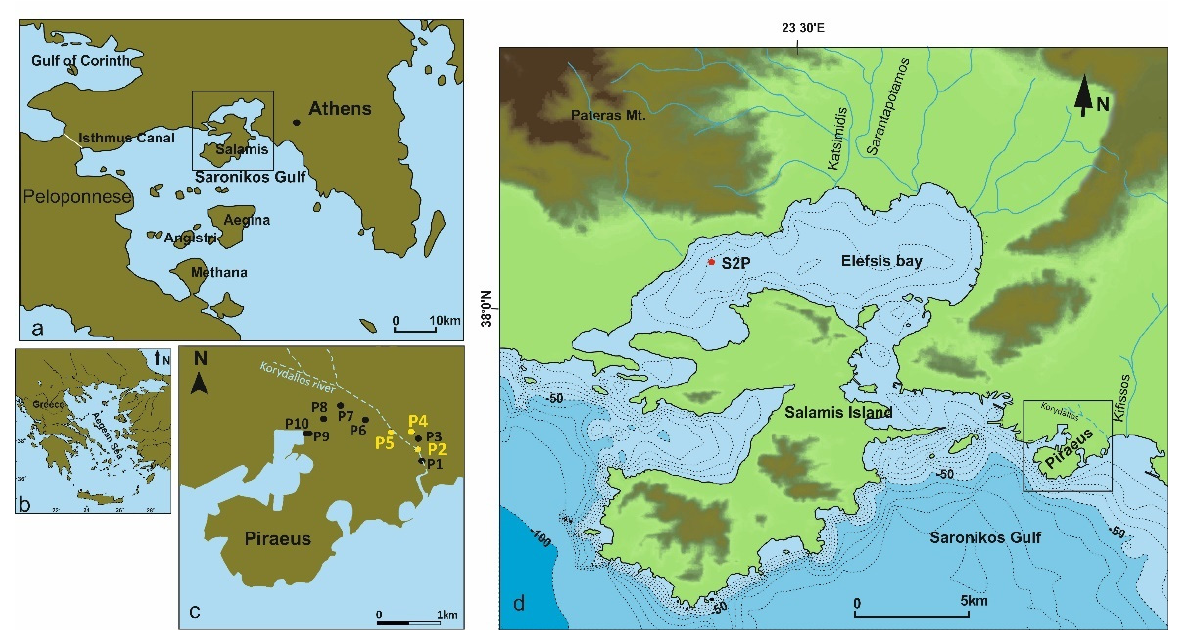
Figure 1. Map of the study area: ( a ) map showing the Saronikos Gulf; ( b ) Map of Greece where Saronikos Gulf is indicated; ( c ) Piraeus coastal plain showing the location of boreholes P2, P4, P5; ( d ) Elefsis bay showing the S2P coring location (source Hellenic Navy Hydrographic Service).